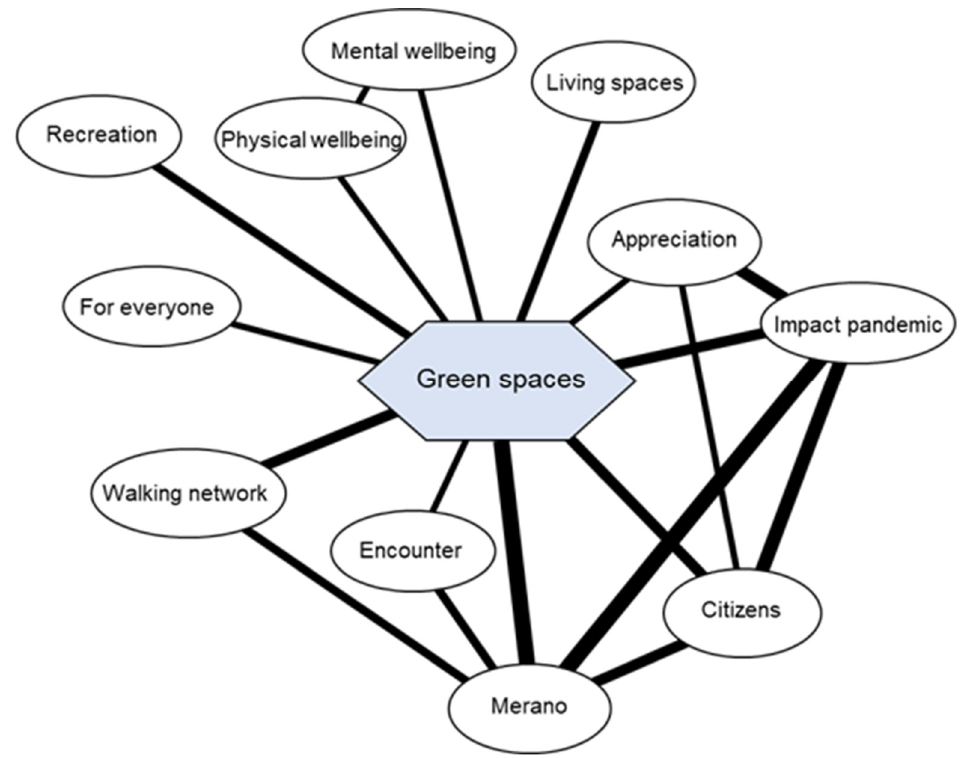
Figure 6. Green spaces in Merano (N = 14, expansion factor = 5).